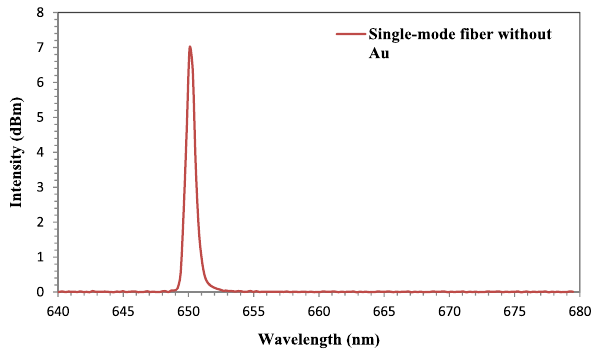
Figure 11. Output spectrum of the fiber-optic sensor without Au NPs.